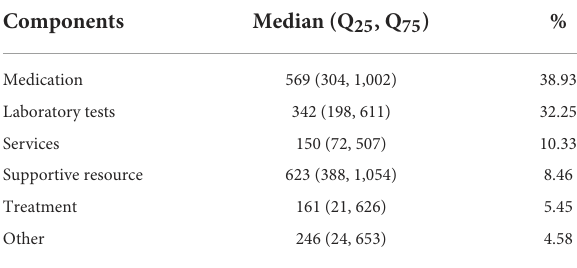
TABLE 3 Components of hospitalization cost (USD). TABLE 4 Differences in hospitalization costs among areas and hospital tiers